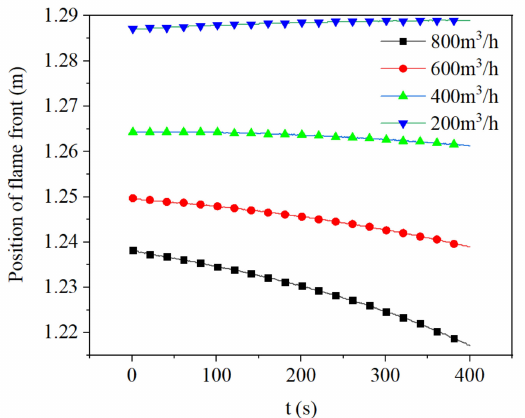
Figure 18. Change of flame front position with time at different inlet flow rates with X CH